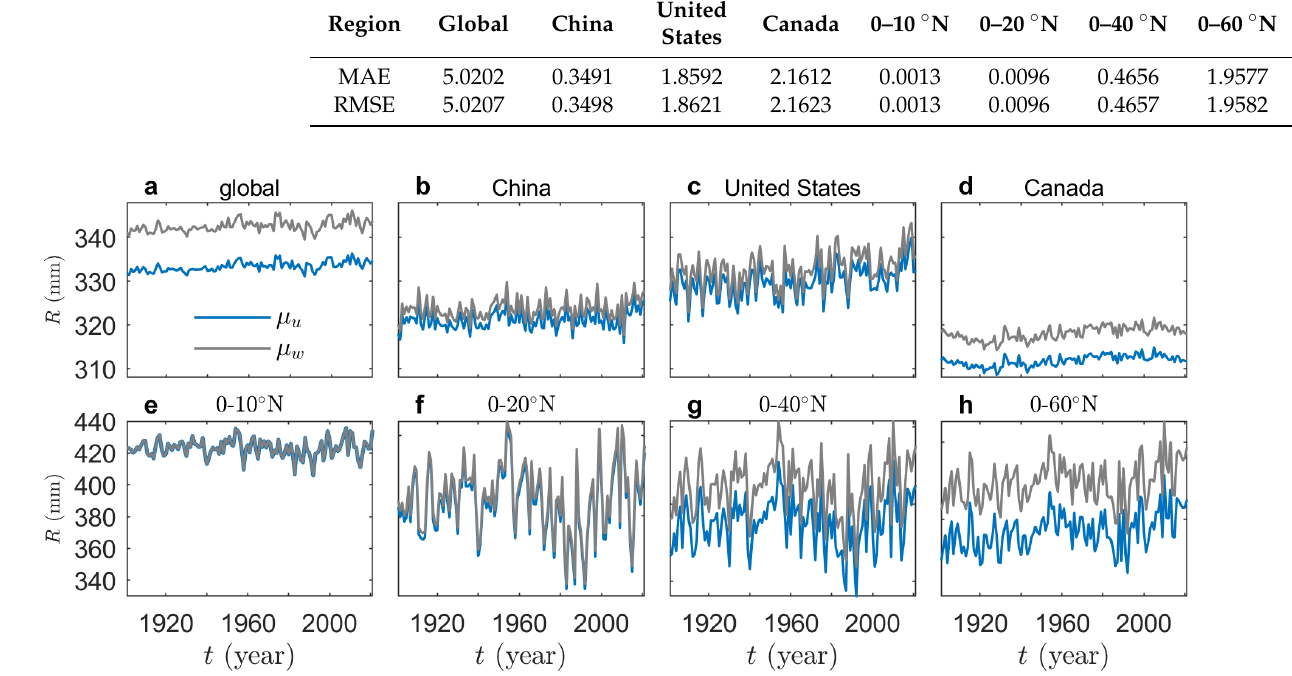
Figure 3. As in Figure 2 but for the precipition.